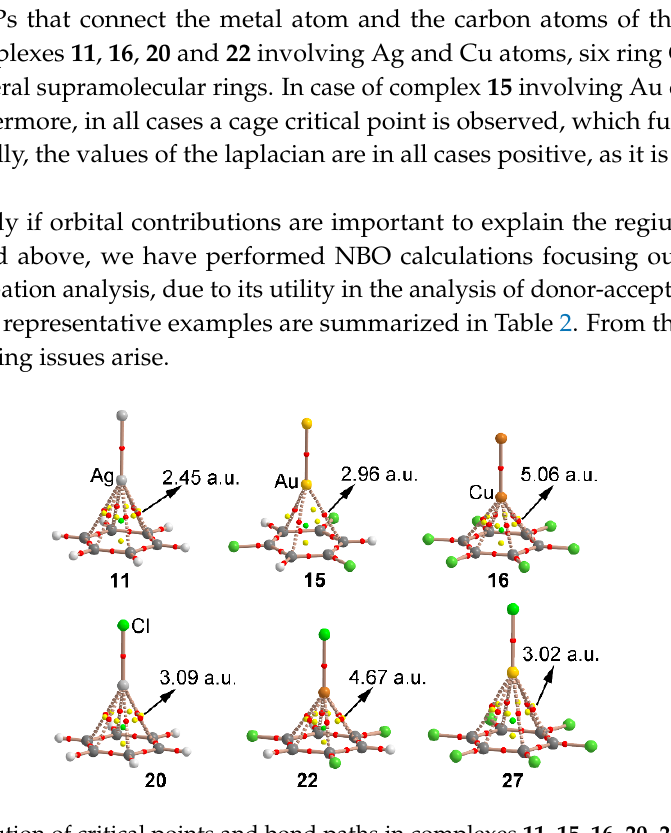
Figure 3. Distribution of critical points and bond paths in complexes 11 , 15 , 16 , 20 , 22 and 27 . Bond, ring and cage critical points are represented by red, yellow and green spheres, respectively. The bond paths connecting bond critical points are also represented. The value of the density at the bond critical point (ρ × 0 2 ) is also indicated in a.u.